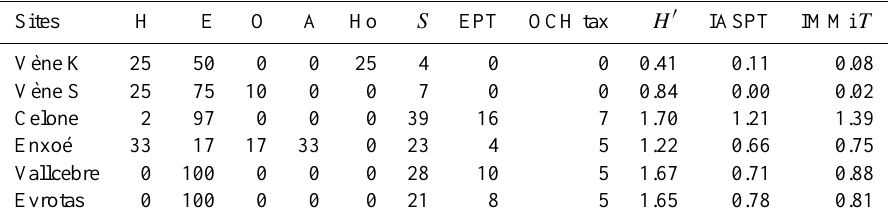
Table 5. Frequency of occurrence of aquatic states during the 3 months before the sampling data together with community and biological water quality metrics for macro-invertebrates at several sites studied in the MIRAGE project. H, E, O, A, Ho=percent time occurrence of the Hyperrheic, Eurheic, Oligorheic, Arheic and Hyporheic states respectively; S =number of taxa; EPT=number of families of Ephemeroptera, Plecoptera and Trichoptera; OCH=Number of families of Odonata, Coleoptera and Heteroptera; H 0 =Shannon-Wiener diversity Index. IASPT and IMMi T indexes are biological quality indexes expressed in